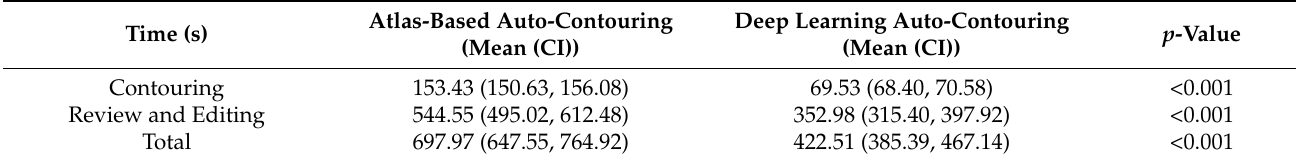
Table 3. Comparison of time required for atlas-based and deep learning